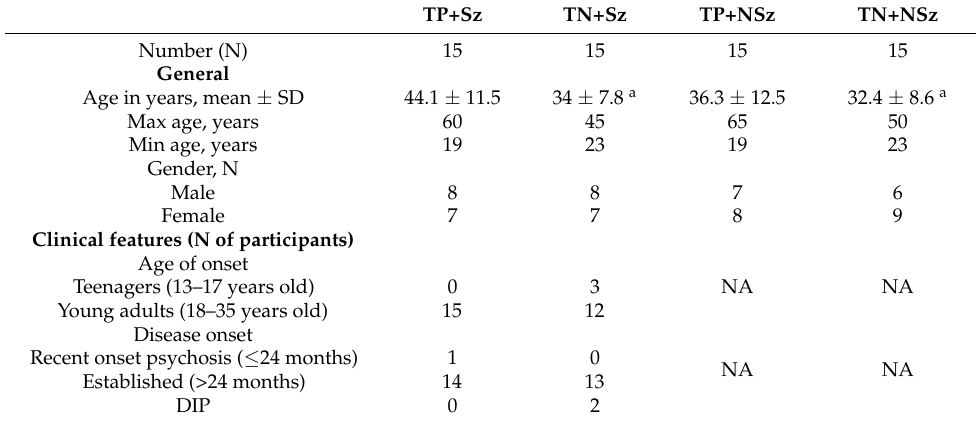
Table 1. Socio-demographic and clinical data of the